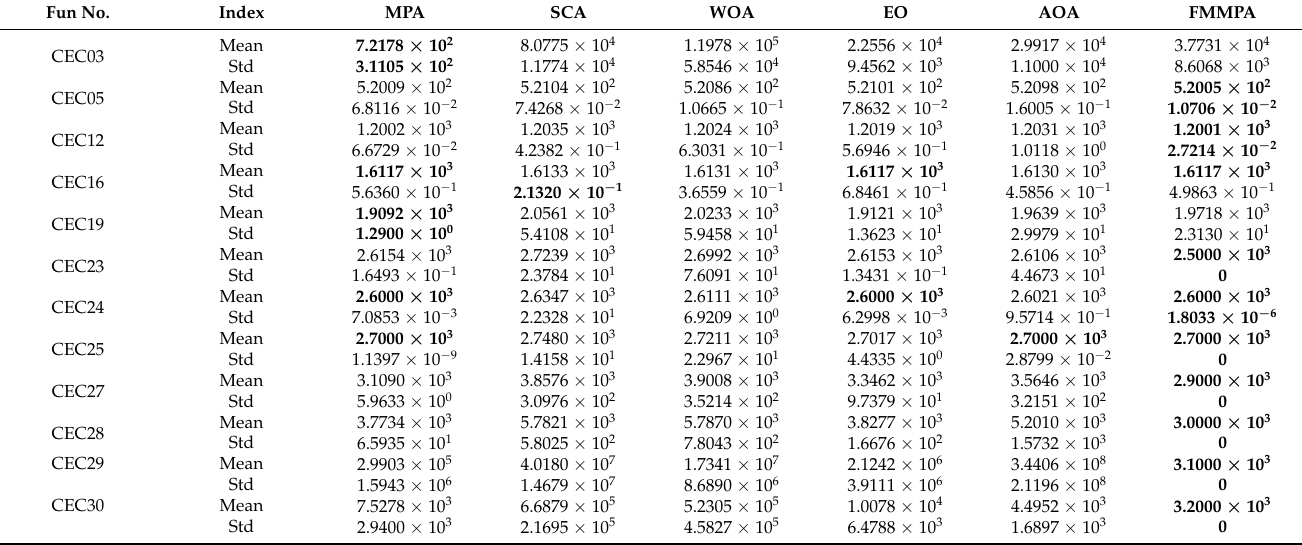
Table 7. CEC2014 function optimization